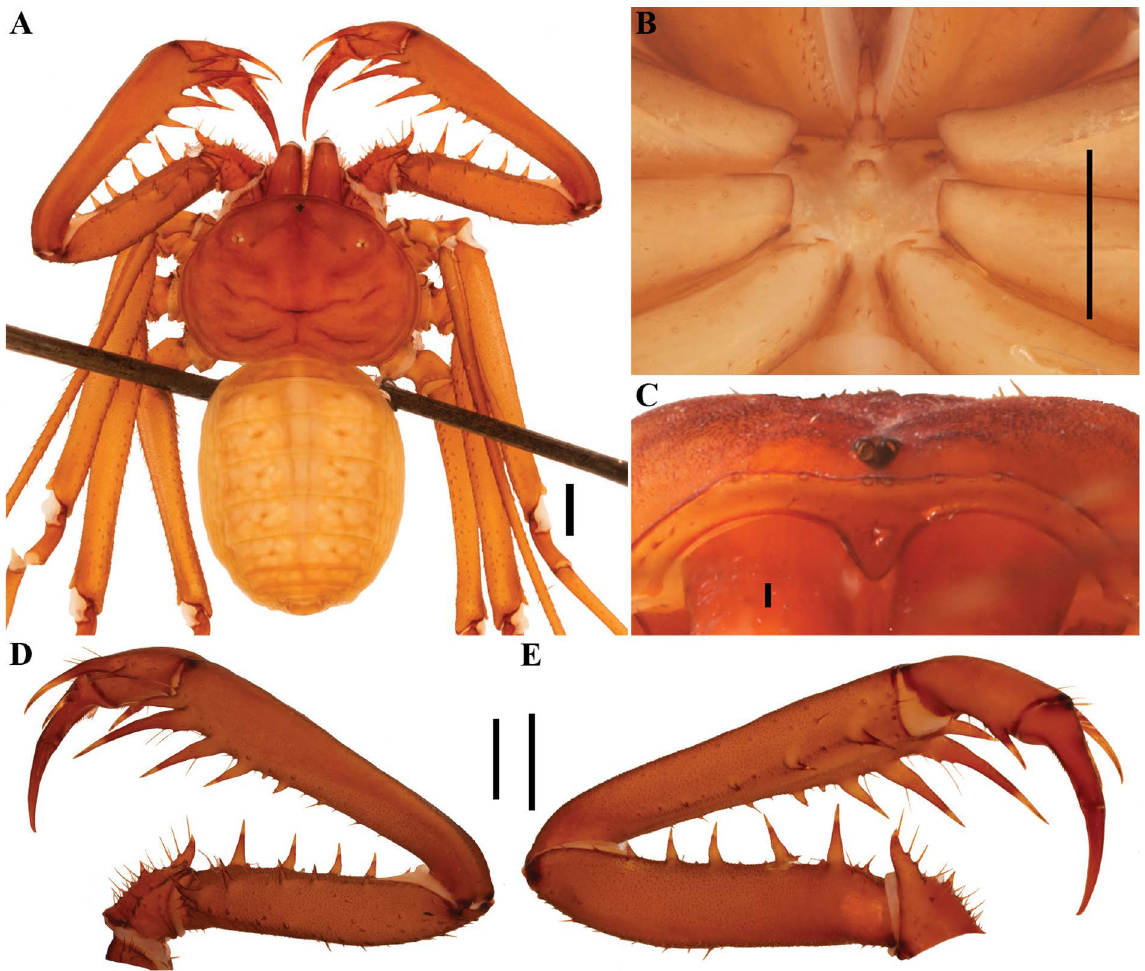
Fig. 148. Sarax socotranus (Weygoldt, Pohl & Polak, 2002) comb. nov. (HLMD EA-45-HT), general morphology, ♂. A . Habitus, dorsal view. B . Sternum, ventral view. C . Frontal process. D . Pedipalp, dorsal view. F . Pedipalp, ventral view. Scale bars: A–B, D–E = 1 mm; C = 0.1